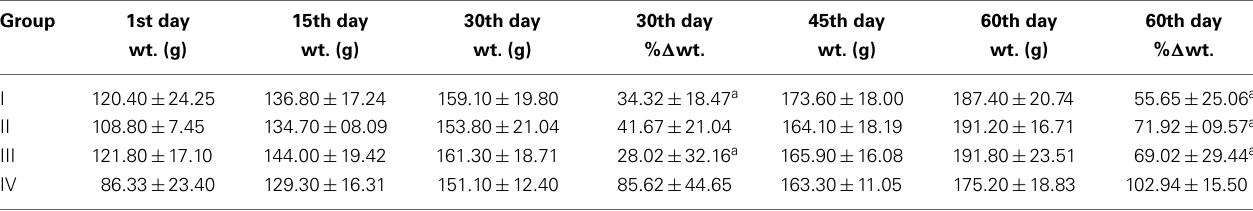
Table 1 | Effect of HLE-FP on body weight in the sub-chronic oral toxicity study.